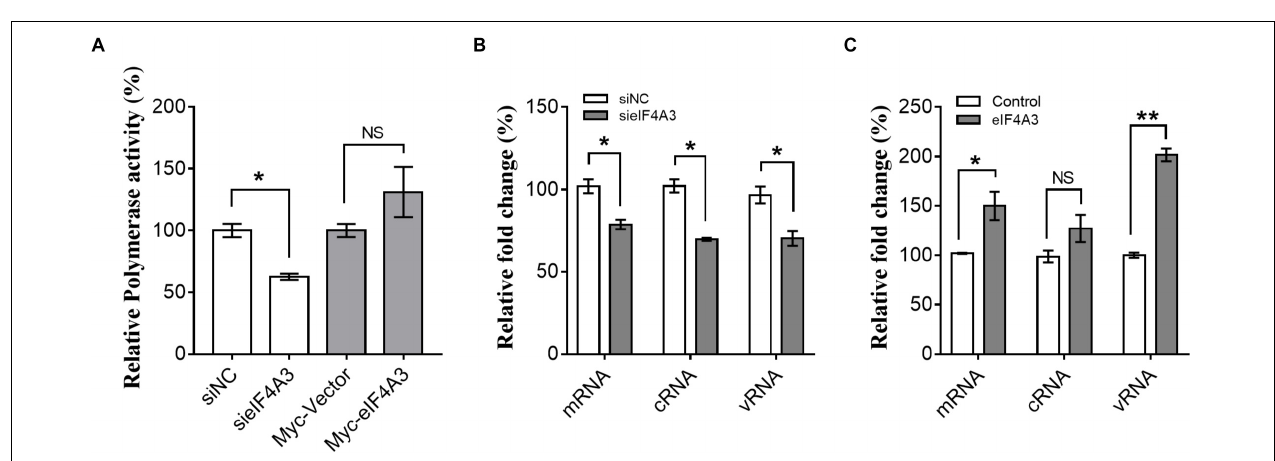
FIGURE 4 | Knockdown endogenous eIF4A3 impairs influenza virus replication. HEK-293T cells were transfected with negative control (NC) siRNA or sieIF4A3. (A) Cells were harvested at 36 h post-transfection to evaluate eIF4A3 protein knockdown efficiency by immunoblot analysis. (B) Thirty-six hours after post-transfection of siRNA, NC and eIF4A3 knockdown cells were infected with influenza A/Guangdong/V at an MOI of 0.01, and then the resulting infectious viral particles were harvested and subjected to TCID 50 analyses on MDCK cells at 12, 24, 36, and 48 hpi. A549 cells were transfected with eIF4A3 or NC siRNA. (C) Cells were harvested at 36 h post-transfection to evaluate eIF4A3 protein knockdown efficiency by immunoblot analysis. (D) Thirty-six hours after post-transfection of siRNA, negative control and eIF4A3 knockdown cells were infected with influenza A/Guangdong/V at an MOI of 0.1, and then the resulting infectious viral particles were harvested and subjected to TCID 50 analyses on MDCK cells at 12, 24, 36, and 48 hpi. The data are shown as means ± SD ( n = 3) and the significance was calculated using an unpaired t -test ( ∗ p < 0.05; ∗∗ p < 0.01).